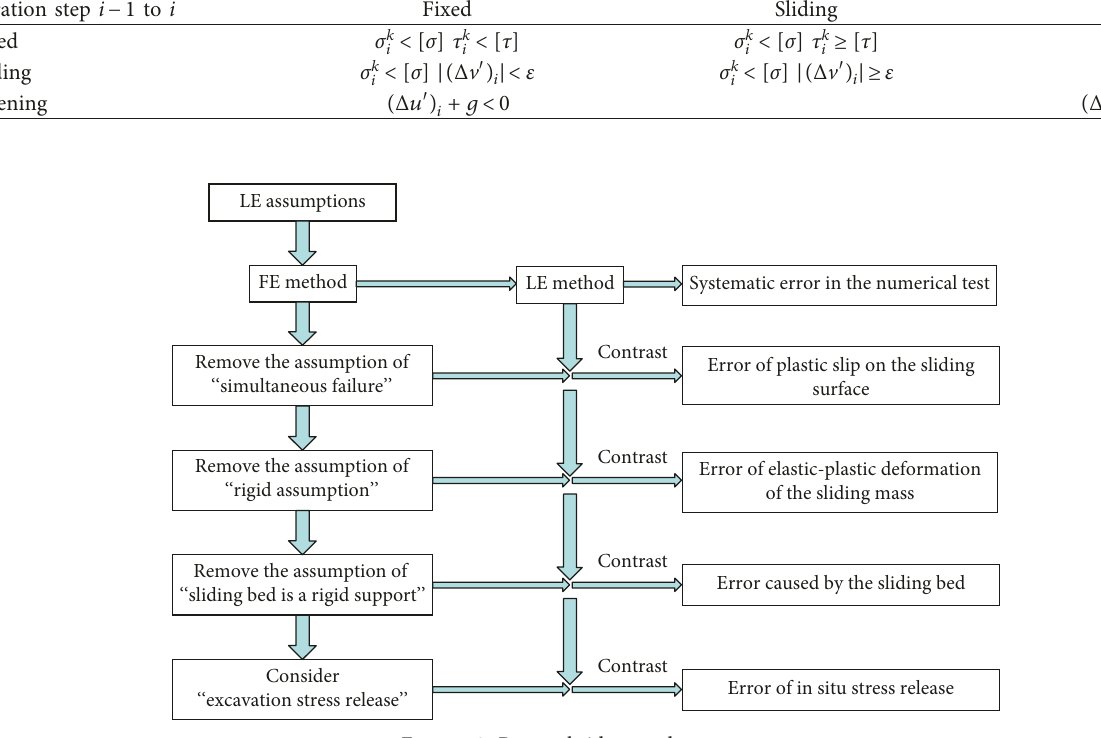
Figure 3: Research ideas and processes.